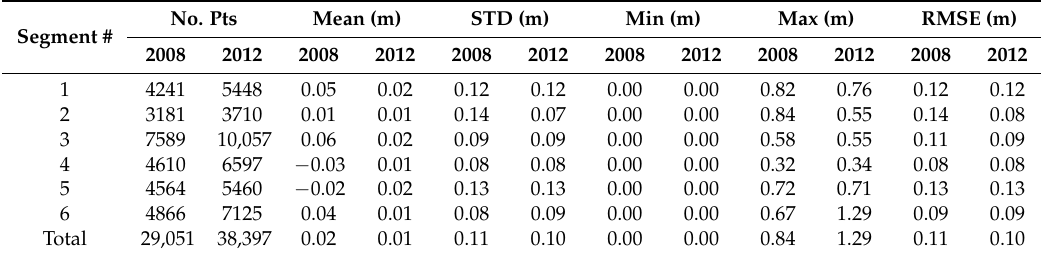
Table 1. Accuracy assessment of the differences between the interpolated DEM and LiDAR point cloud of the six segments shown in Figure 4 for the 2008 and 2012 DEMs.